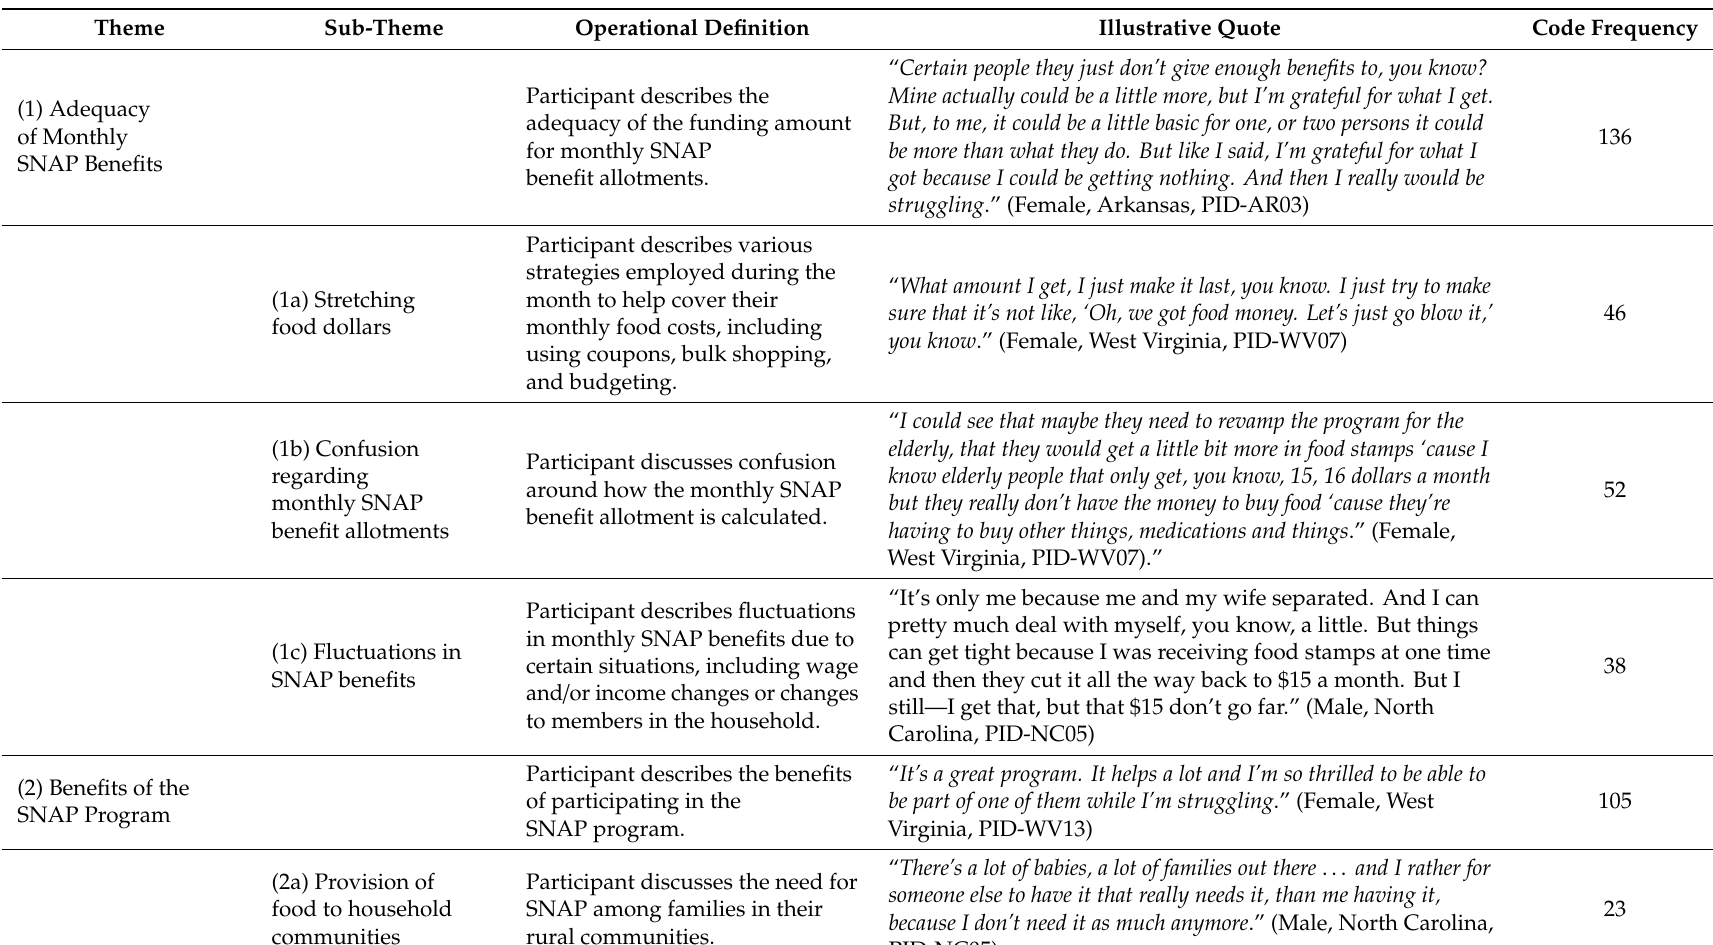
Table 3. Themes, sub-themes, operational definitions, illustrative quotes, and code frequency, N =